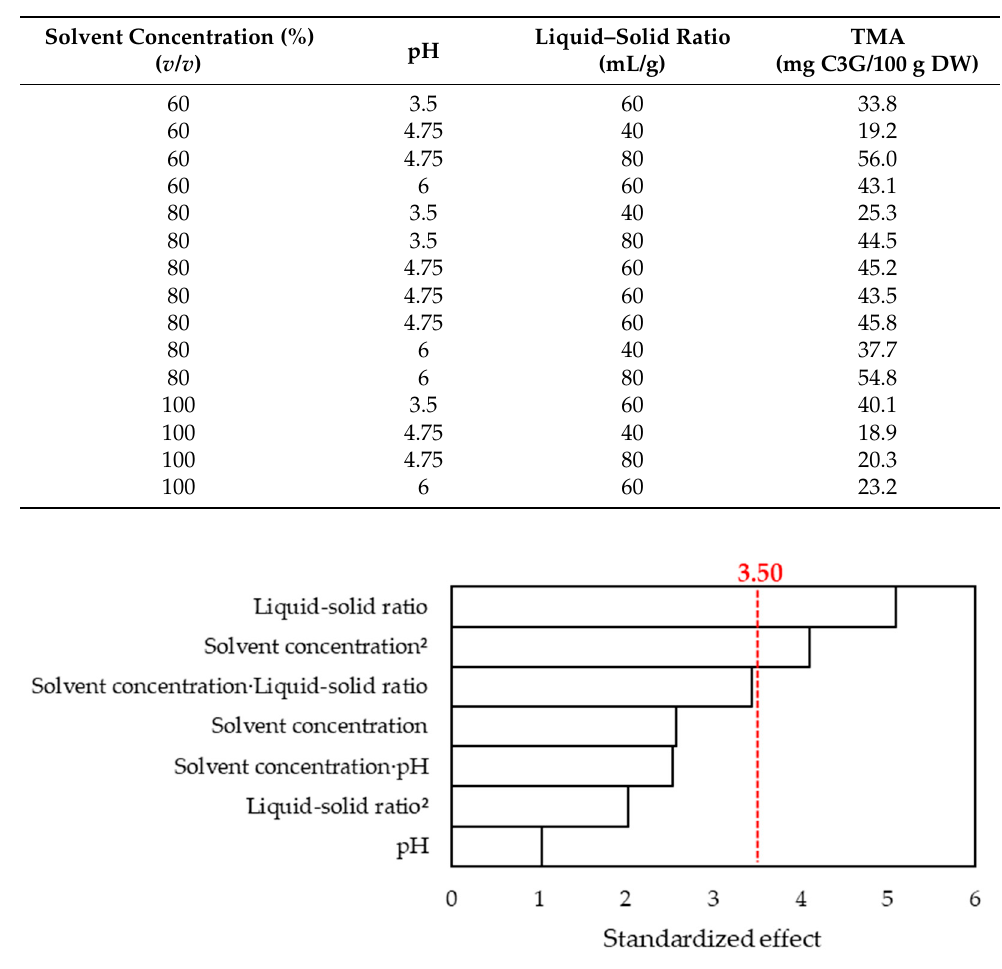
Table 5. Box–Behnken design and values of the total monomeric anthocyanin concentration.